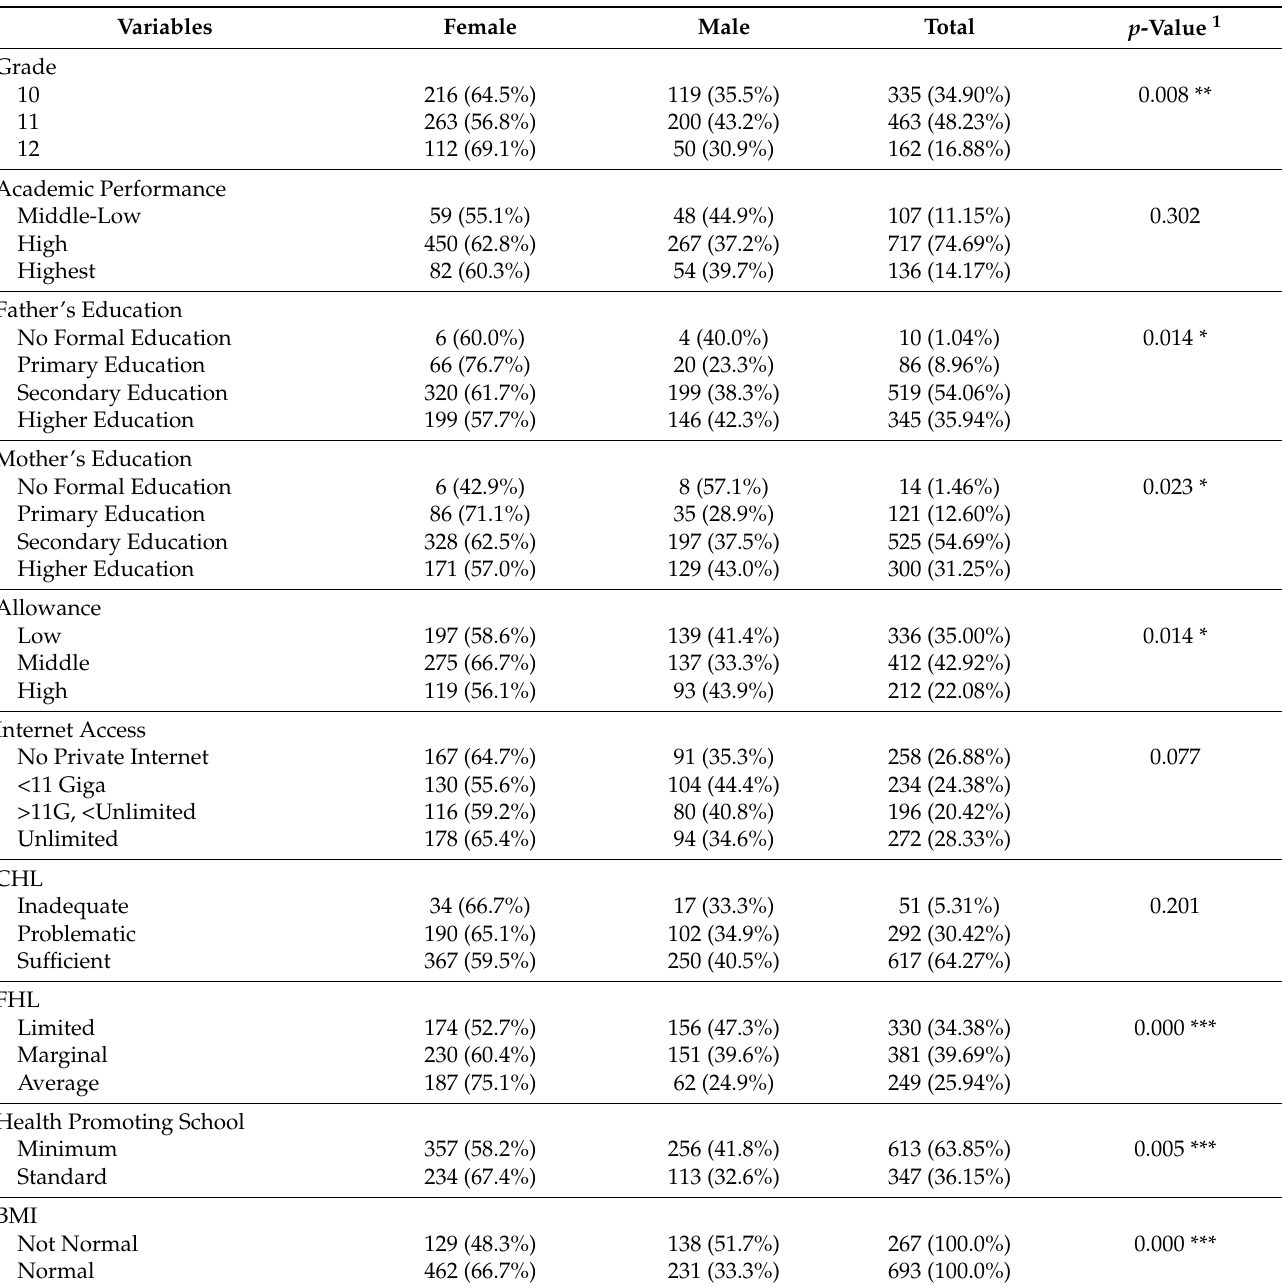
Table 1. Socioeconomic characteristics of high school students in Surabaya,